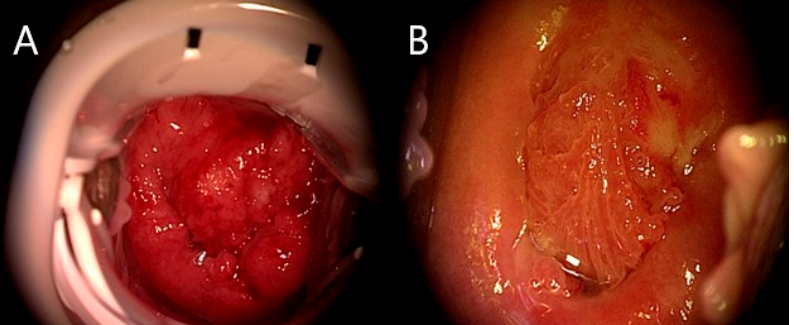
Figure 2. Cervical cancer seen during colposcopic investigation before ( A ) and after ( B ) chemother- apy.